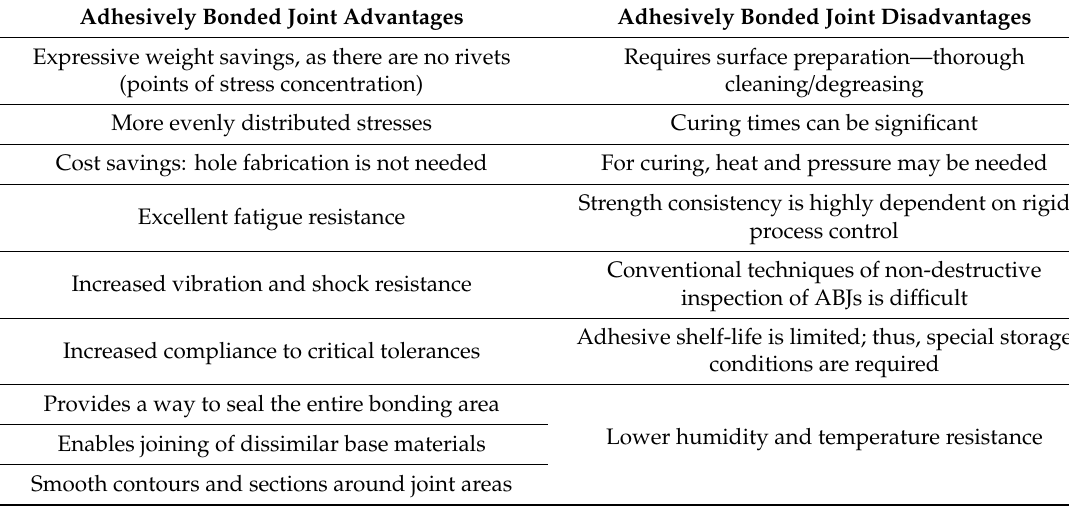
Table 2. ABJs’ advantages and disadvantages